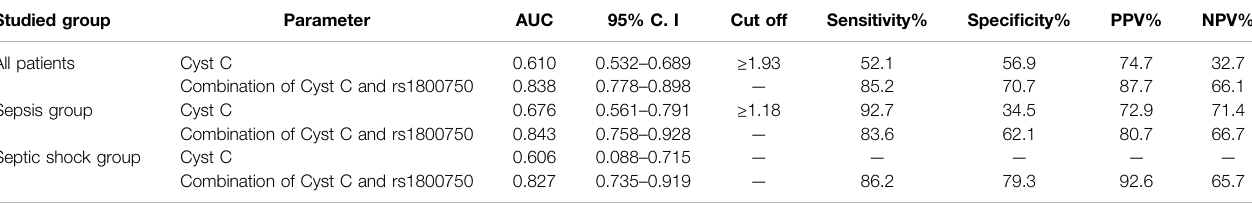
TABLE 4 | Validity (AUC, sensitivity, speci fi city) for Cyst C to discriminate S-AKI patients (No. (cid:1) 142) from non-AKI (No. (cid:1) 58) in all patients. Studied group